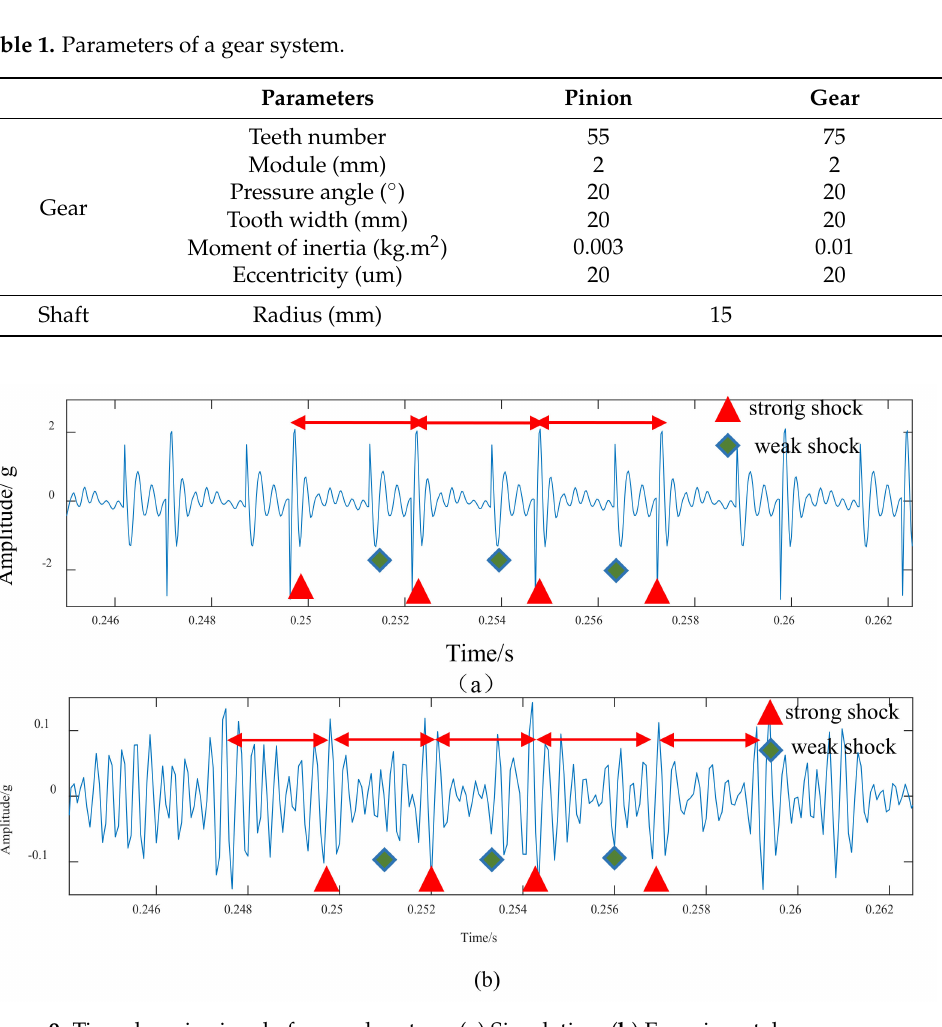
Figure 9. Time domain signal of normal system: ( a ) Simulation, ( b )